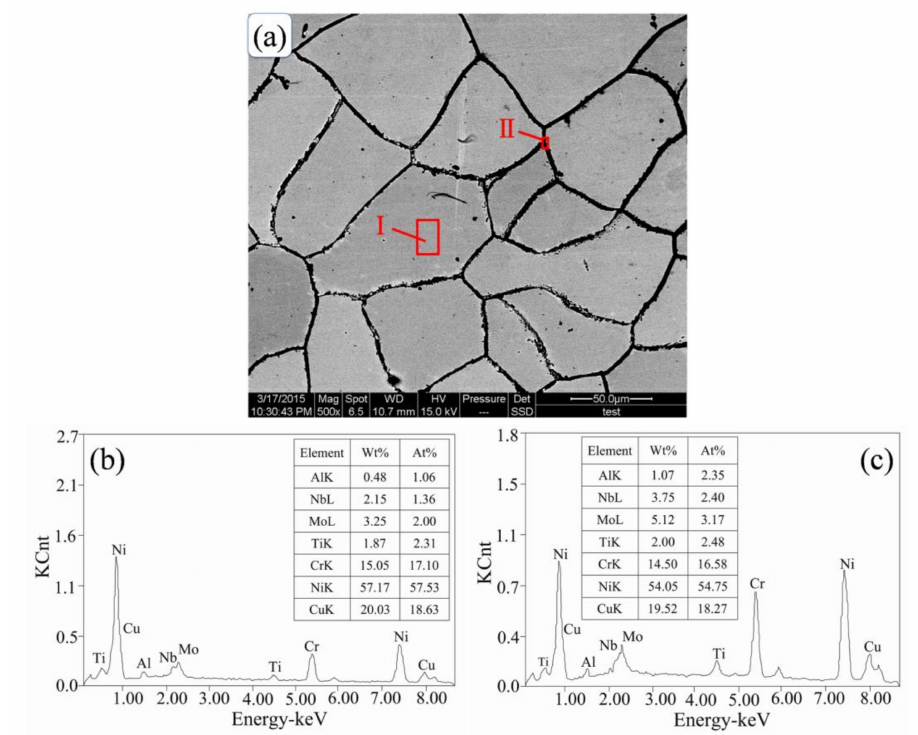
Figure 4. SEM micrographs of heat-treated Ni-Nb3 alloy along with EDS maps: ( a ) SEM micrograph; ( b ) EDS map of zone I in ( a ); ( c ) EDS map of zone II in ( a ).